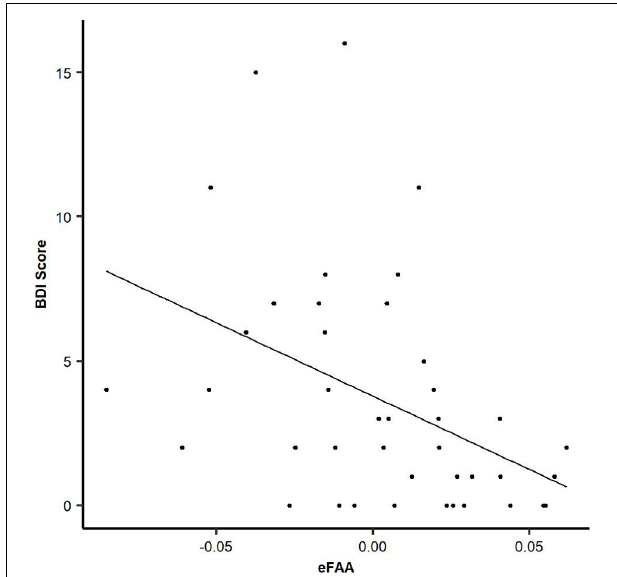
FIGURE 4 | Objective eFAA index correlates with subjective depression symptoms. There was a significant negative correlation between BDI score and eFAA (threat modulation of FAA). When BDI score was higher, eFAA was more negative. All three groups (MTBI Symptomatic, MTBI Non-symptomatic, Control) are included in the analysis and in the scatter